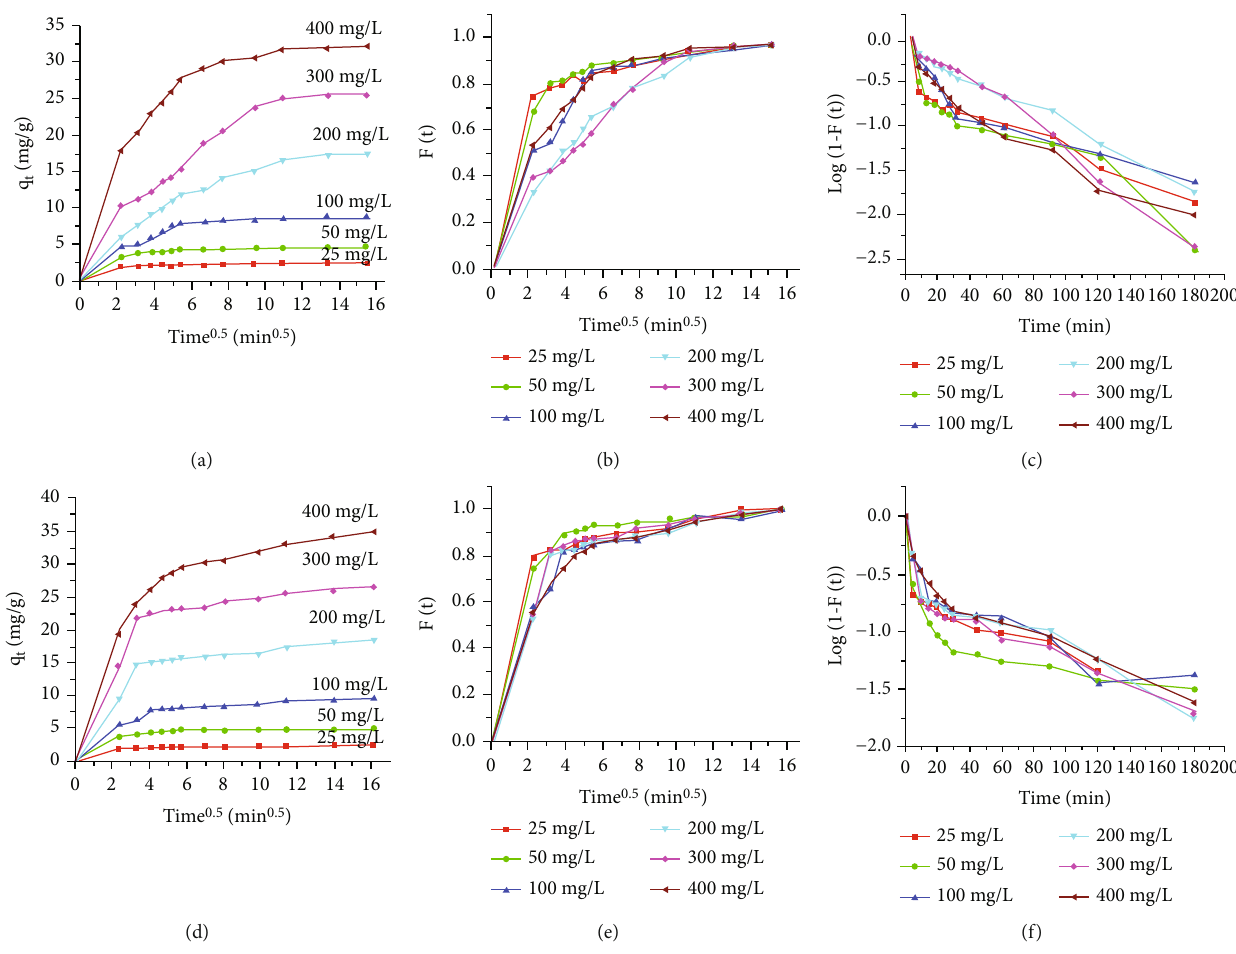
Figure 12: Intraparticle di ff usion plot of Red 2BN on adsorbents of (a – c) JPAC and (d – f) JPAC/TiO